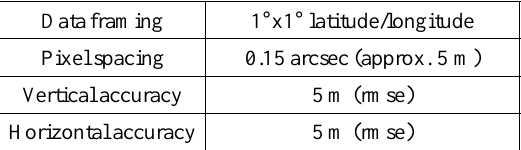
Table 1. Specifications of ‘ALOS World 3D’ DSM Data